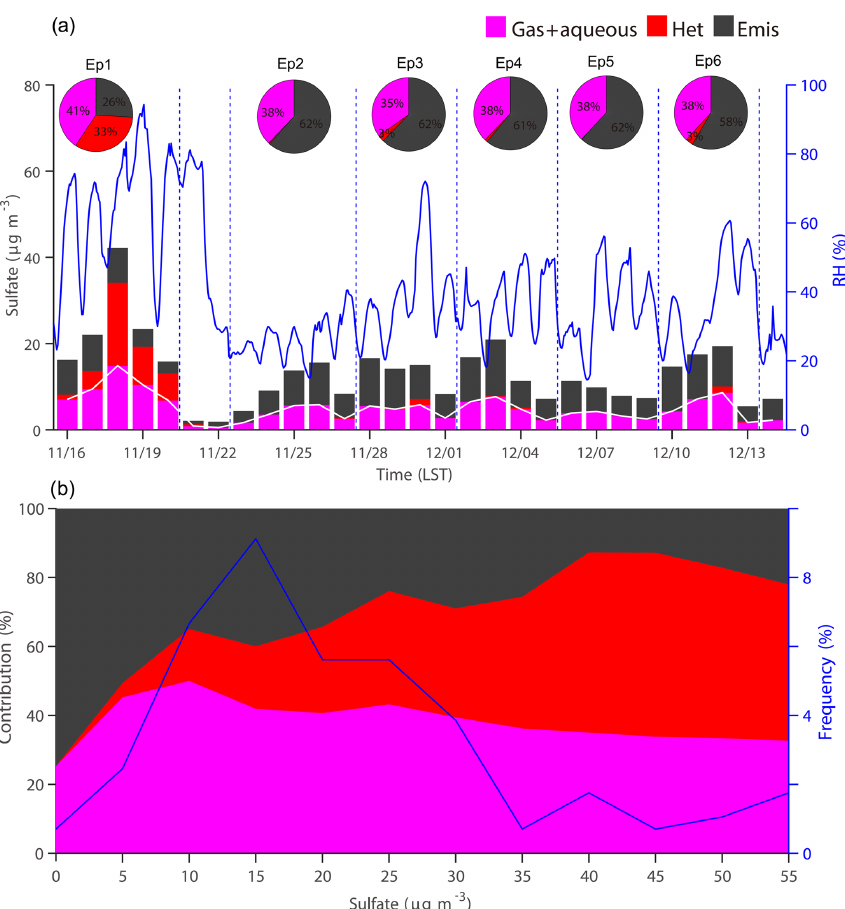
Figure 13. The contribution of different formation pathways for sulfate in Beijing. (a) The daily average. The blue line shows relative humidity in Beijing. The pie charts show the average contribution of different pathways during each episode. (b) The relationship between the sulfate concentration and different formation pathways of sulfate during Ep1. “Het” refers to the contribution of heterogenous chemistry of SO 2 , and “Emis” refers to the contribution of primary sulfate. Sections of the pie charts where the values are not specified represent values of less than